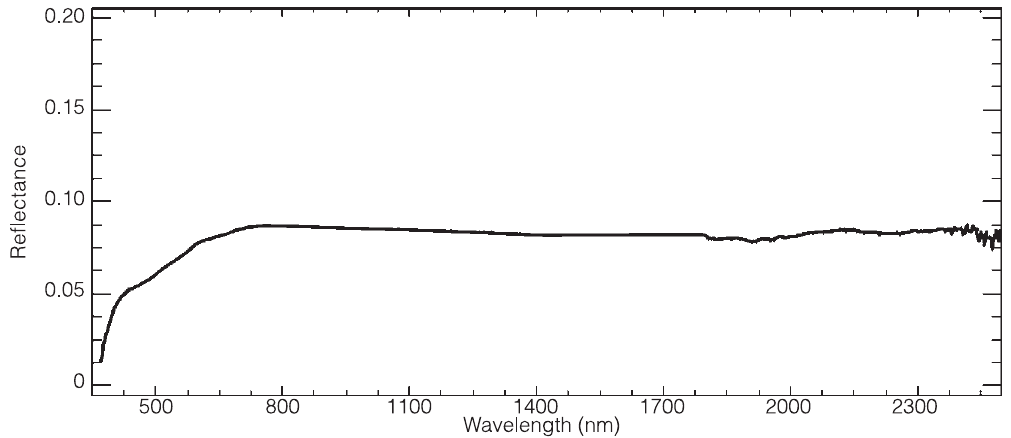
Fig. 4. Volcanic rock refl ectance measured in laboratory and during MVRSS « Sicily 1997 » campaign on Mt. Etna (1972 lava fl ow). Refl ectance value of 0.05 in wavelength range 454-474